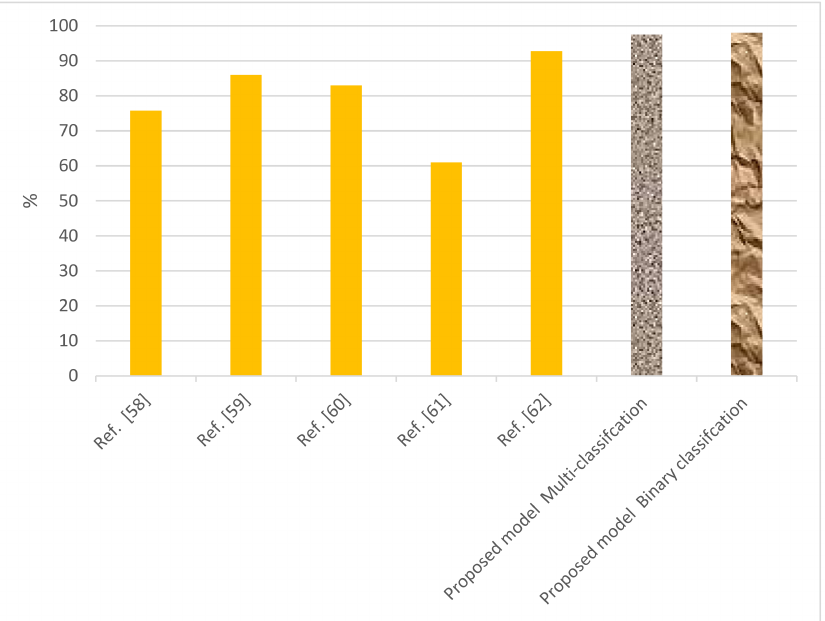
Figure 12. Comparison of performance of the proposed system with different existing systems for detection of EDoS